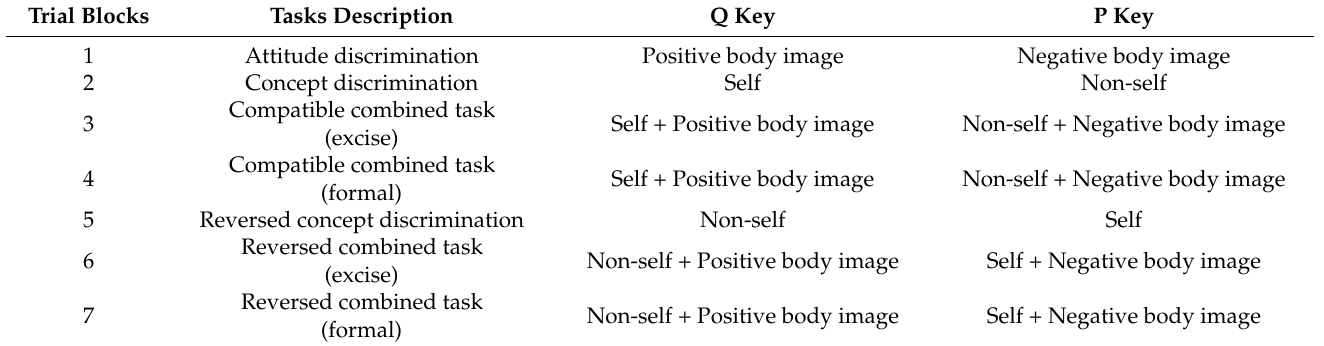
Table 3. The procedures of